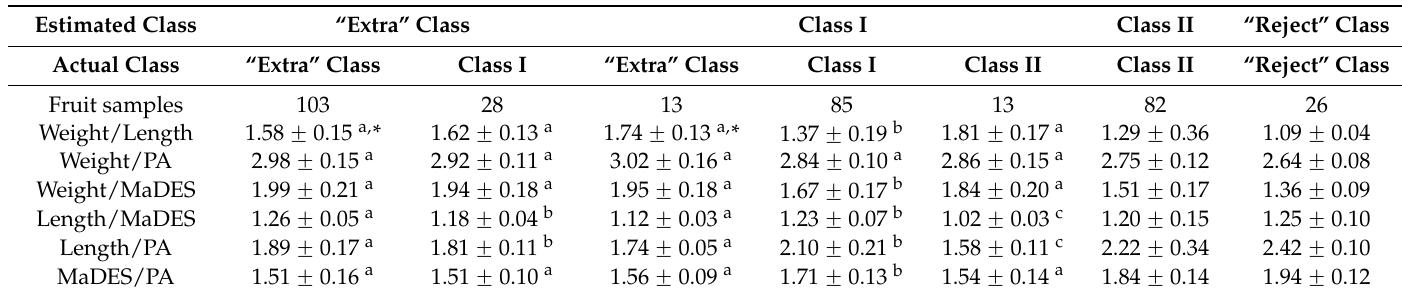
Table 3. Comparison of six ratios (Mean ˘ standard deviation) based on the four measurable parameters for groups of actual classes in the estimated ones from the validation dataset (350